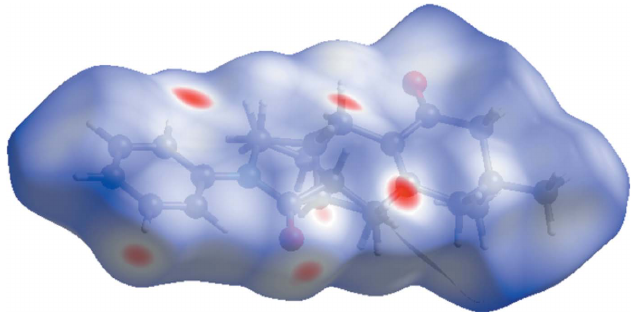
Figure 3 The Hirshfeld surface mapped over d norm in the range (cid:5) 0.2740 (red) to 1.7368 (blue) a.u.